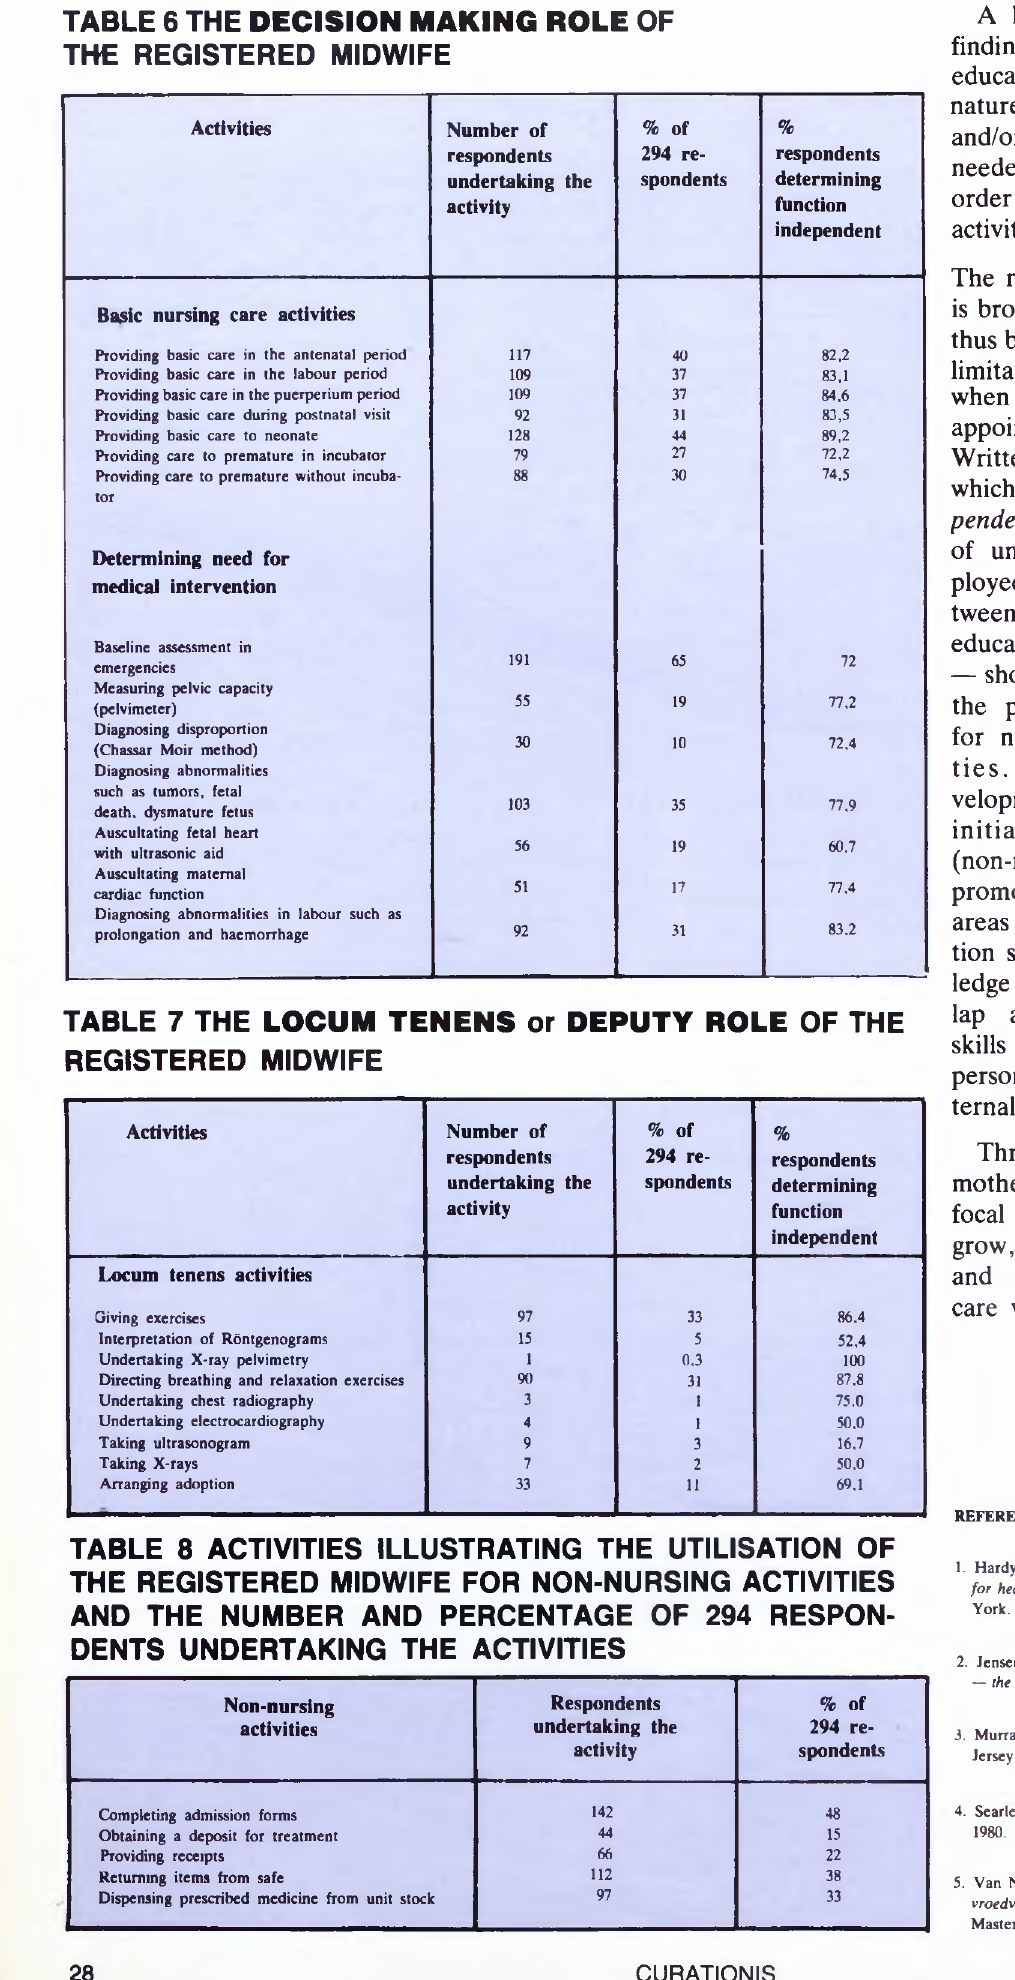
TABLE 6 THE DECISION MAKING ROLE OF THE REGISTERED MIDWIFE